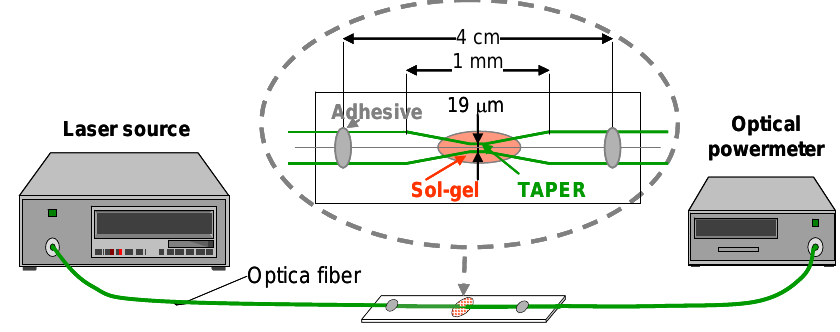
Figure 6. Transmission set up with a tapered optical fiber based evanescent wave